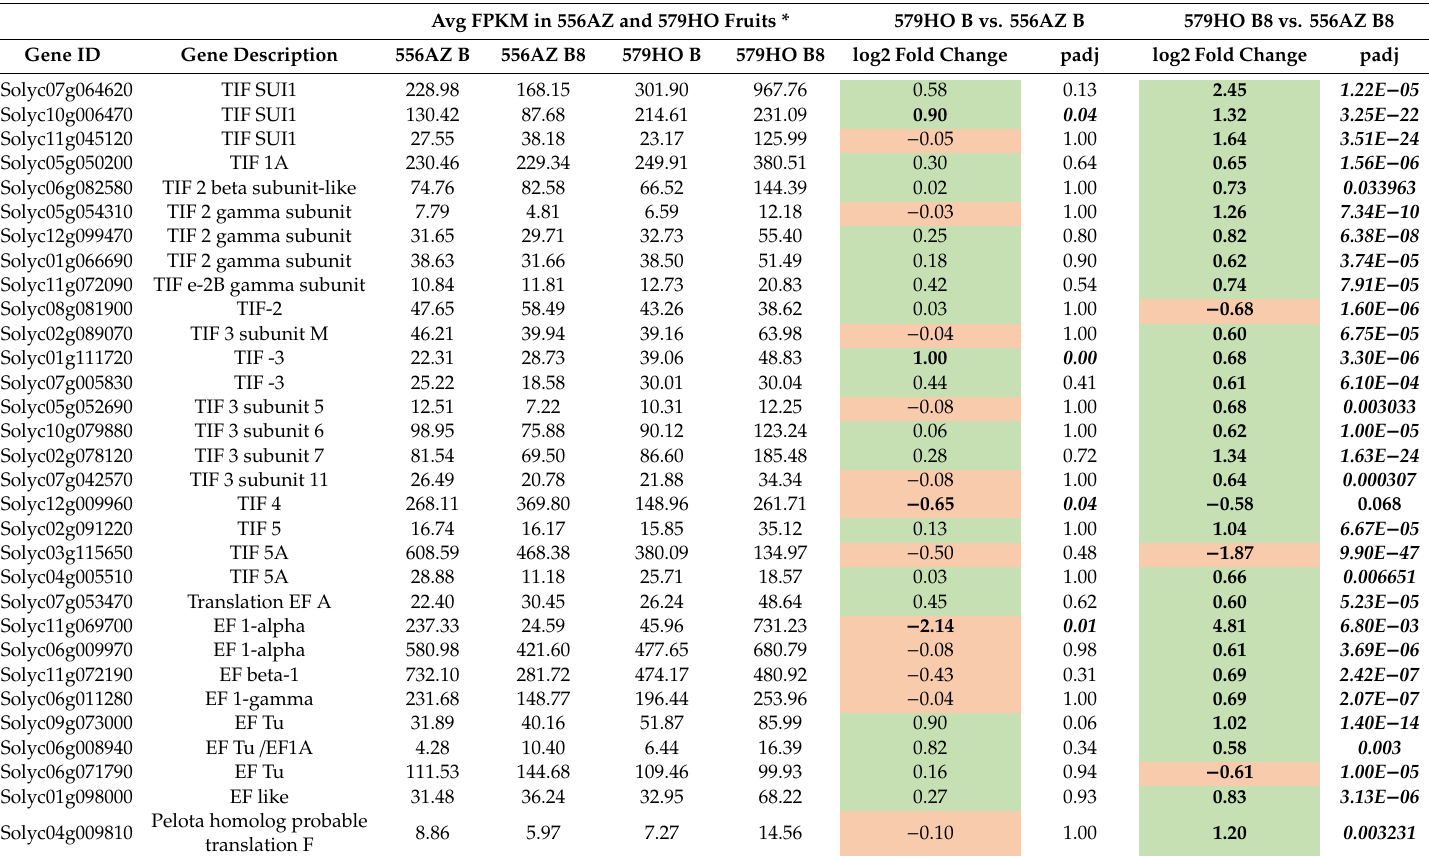
Table 3. Di ff erential expression of translation protein genes in 556AZ and 579HO tomato fruit at breaker (B) and breaker + 8 (B + 8)